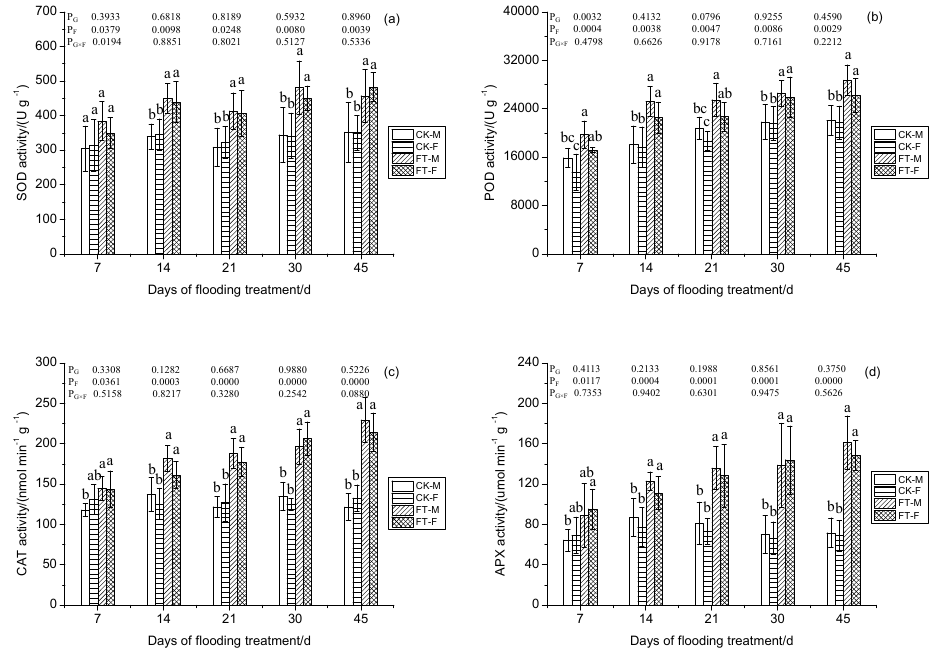
Figure 7. Superoxide dismutase (SOD) ( a ), peroxidase (POD) ( b ), catalase (CAT) ( c ), and ascorbate peroxidase (APX) ( d ) activities of male vs. female Salix viminalis plants at di ff erent times of flooding treatment.